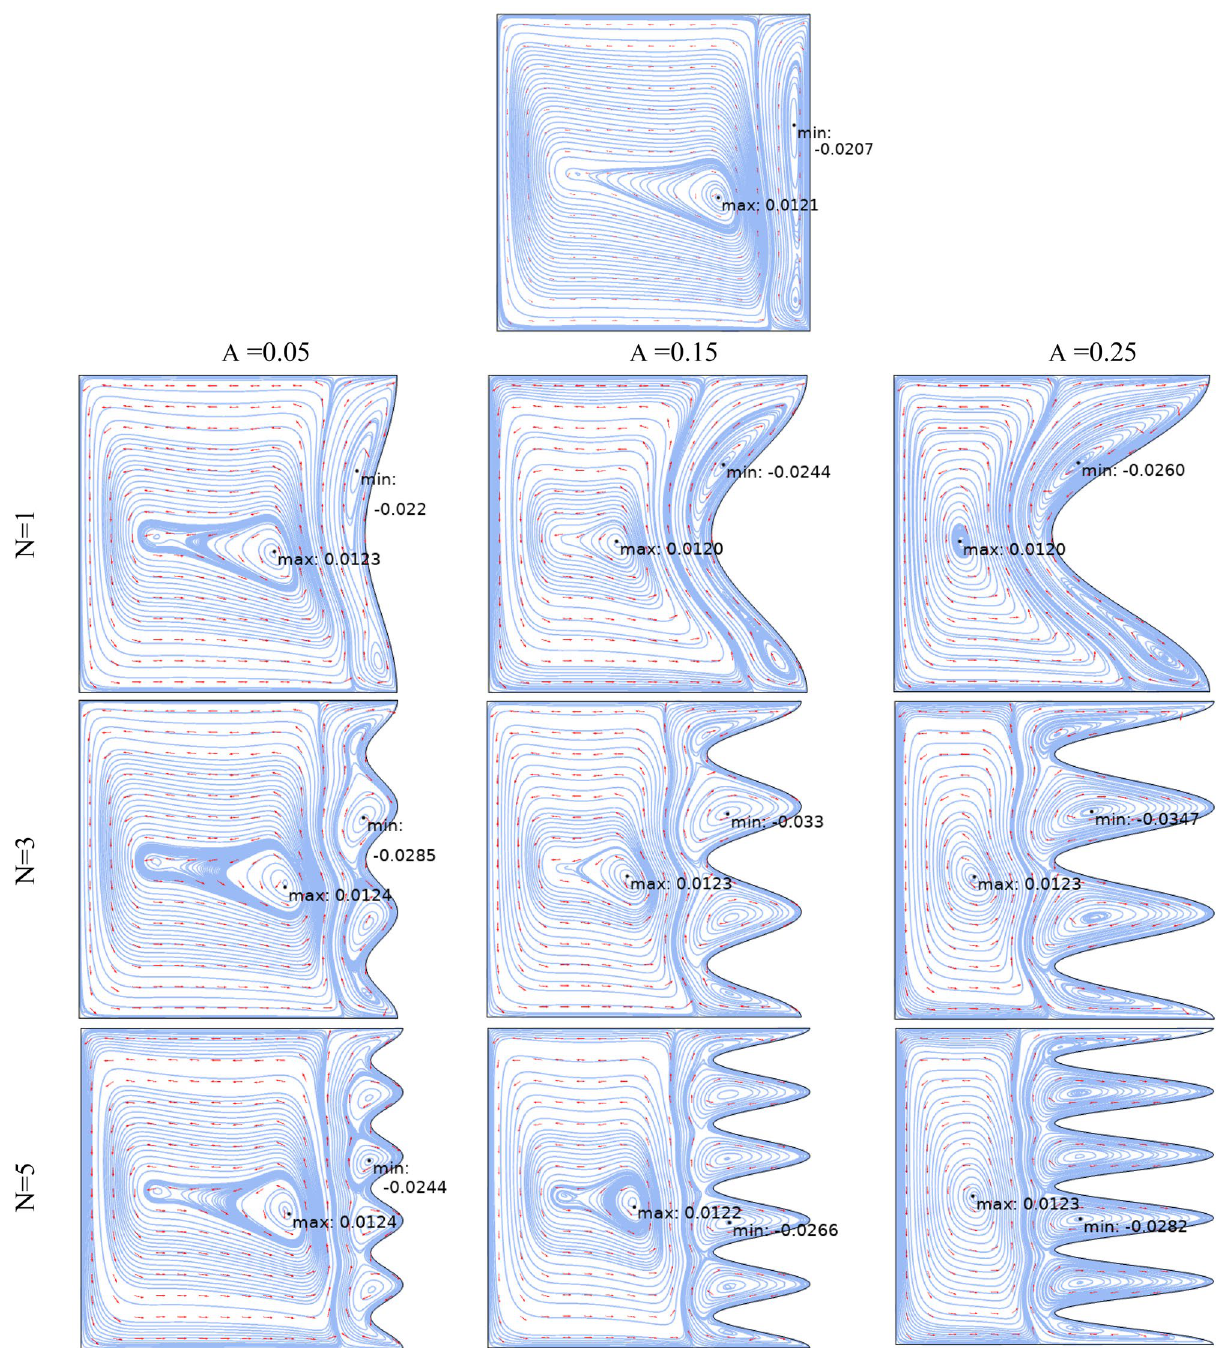
Figure 12. Streamlines and isotherms at (Da = 1e−3, Re = 200, Q = 0, φ = 0.03, Ha = 25, γ = 45, Ri = 10) for Case